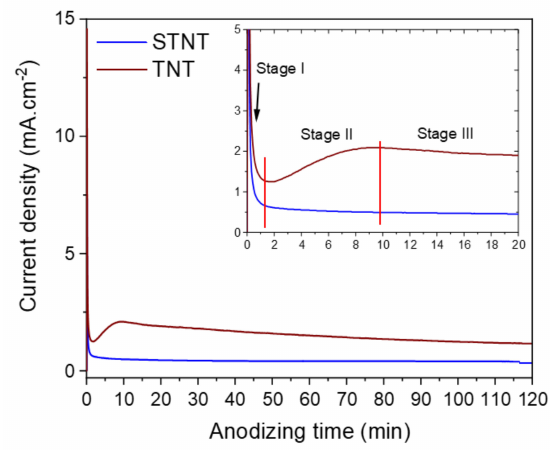
Figure 1. Time-current density plots during anodization for TNT and STNT samples. The inset shows the zoomed-in region around stage II.